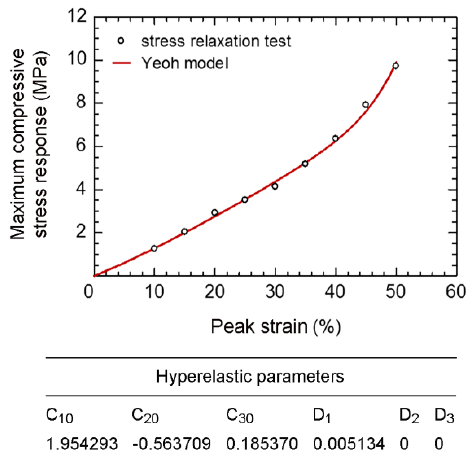
Figure 7. Maximum compressive stress response vs. the peak strain and hyperelastic parameters of disc-A during a hyperelastic period of the stress relaxation test.